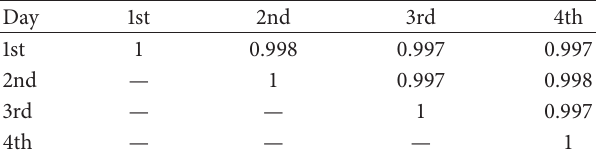
Table 3: Correlation matrix of the two